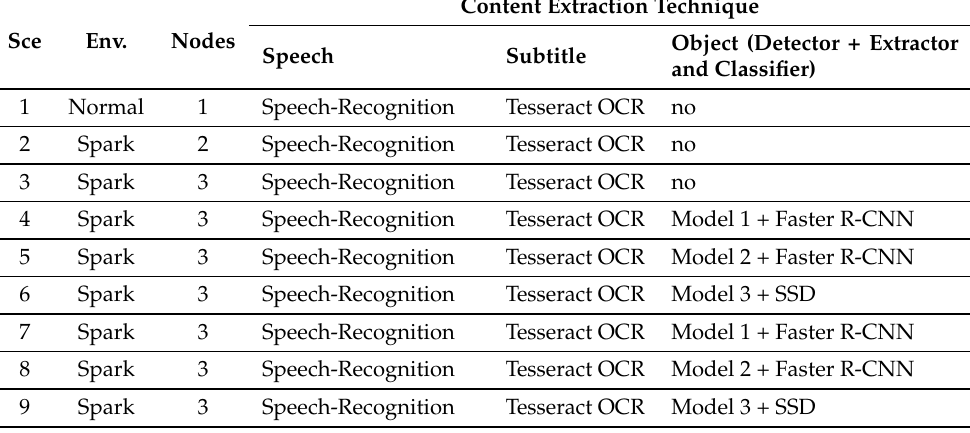
Table 3. Experimental